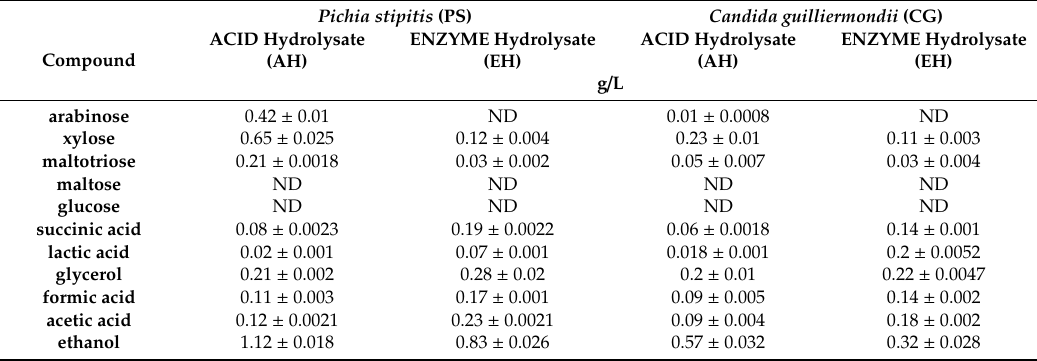
Table 2. Selected compounds in post-cultivation e ffl